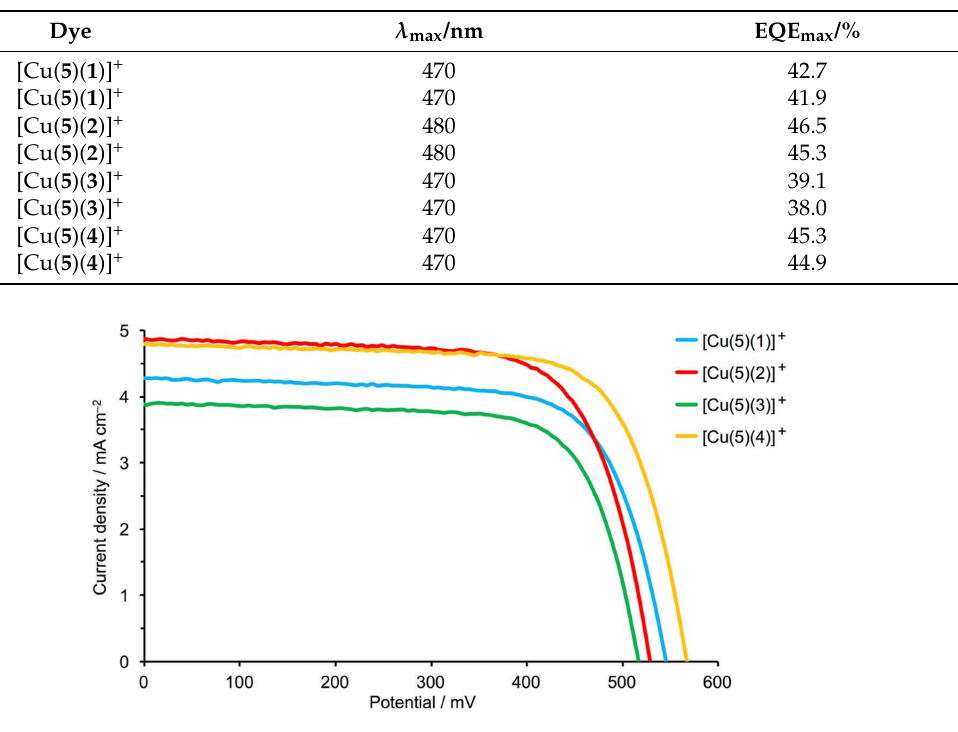
Figure 7. J – V curves for the best performing DSSCs containing dyes [Cu( 5 )(L ancillary )] + (L ancillary = 1 – 4